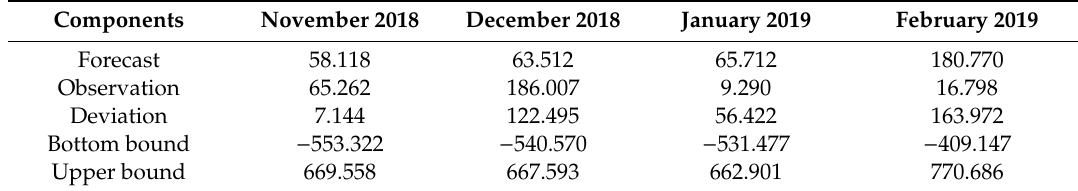
Table A1. Models-2 forecast profit for Bank A in IDR trillion.